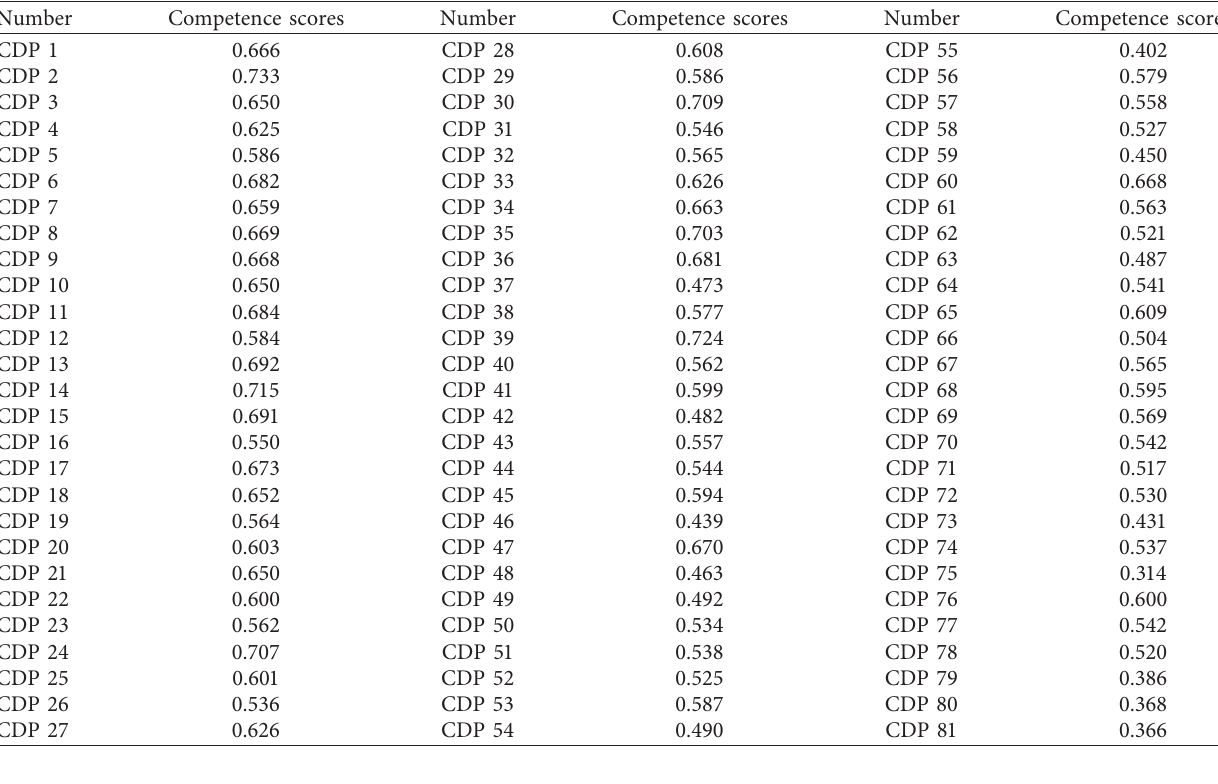
Table 5: Statistical results for overall competence scores. Personnel